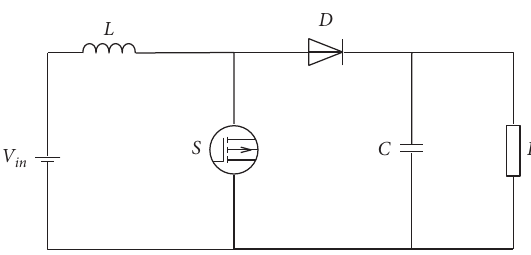
Figure 3: Conventional boost DC-DC